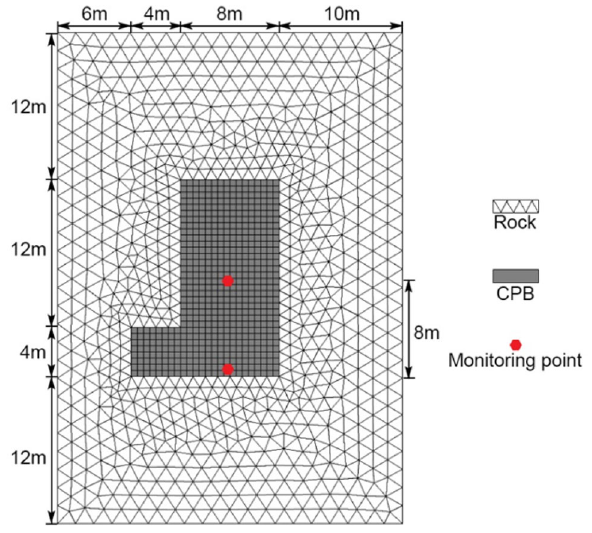
Fig. 14 Mesh and geometry of control